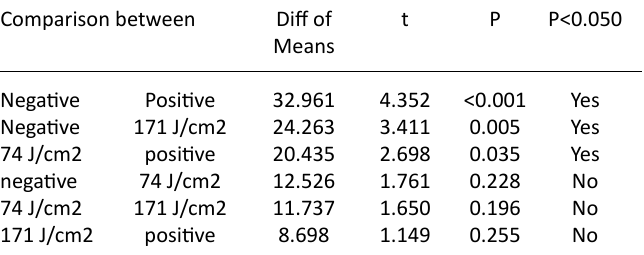
Table 5. Comparison of weight changes in day six Comparison between